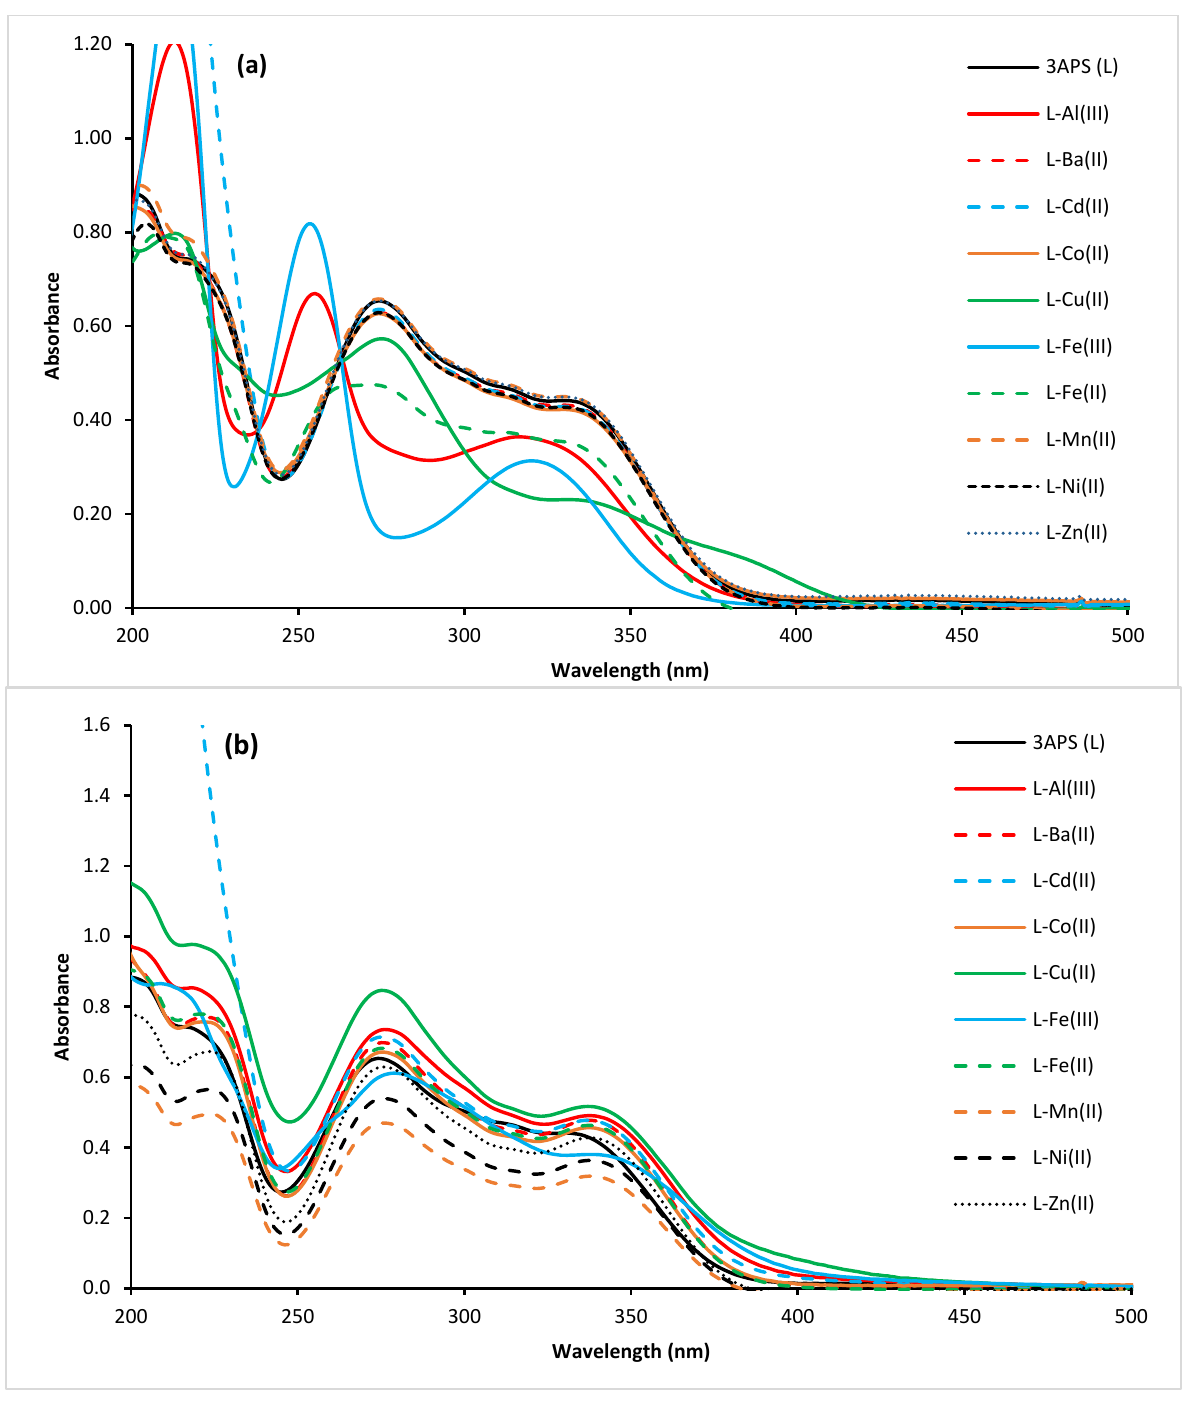
Figure 2. UV–VIS absorption of 3APS (2 × 10 − 5 M) in the absence and presence of tested metal solution (Al(III), Ba(II), Cd(II), Co(II), Cu(II), Fe(III), Fe(II), Mn(II), Ni(II), and Zn(II)) at 1 × 10 − 4 M each in H 2 O–ACN (9:1) ( a ) and in H 2 O–ACN (1:9) ( b ).